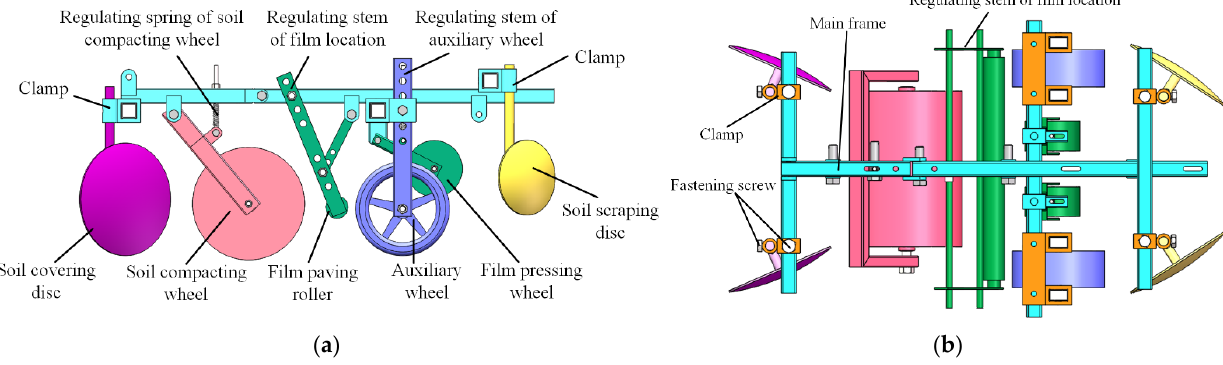
Figure 3. ( a ) Side view of the covering device. ( b ) Top view of the covering device.